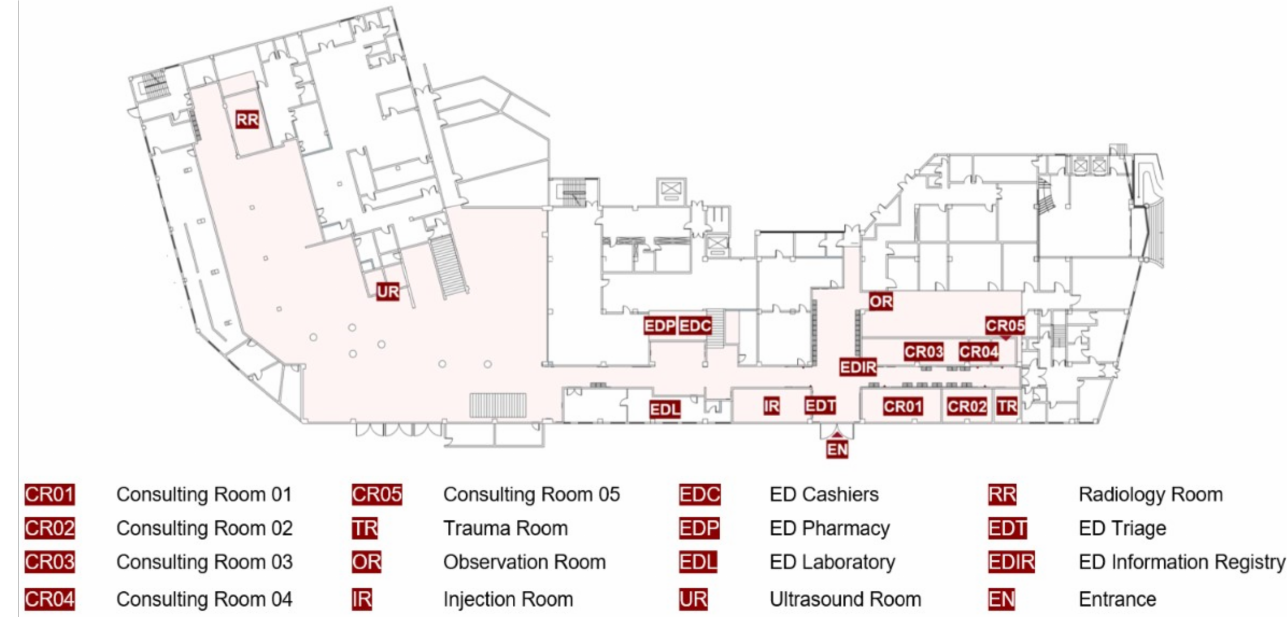
Figure 2. First-floor plan of hospital